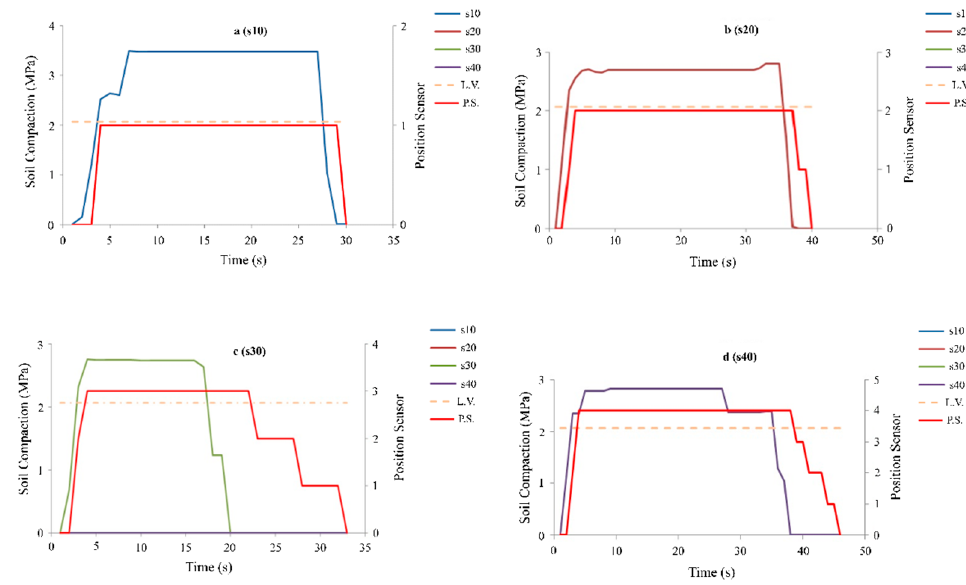
Figure 9. Operating mode of the system and feedback (red line) in the first mode, and the excitation of the compression sensors.